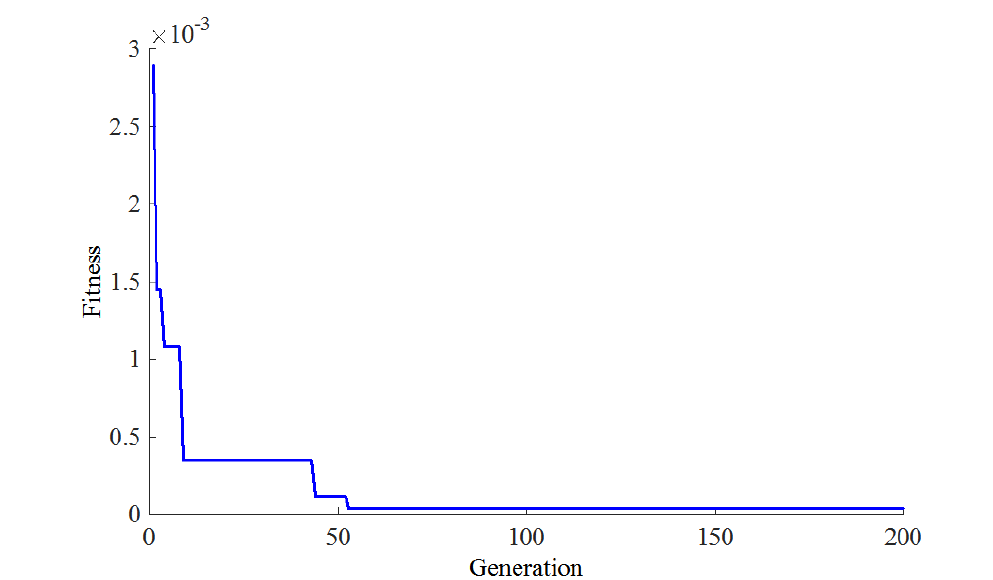
Fig. 5 Variation of fitness index with generation for the clamped-clamped beam